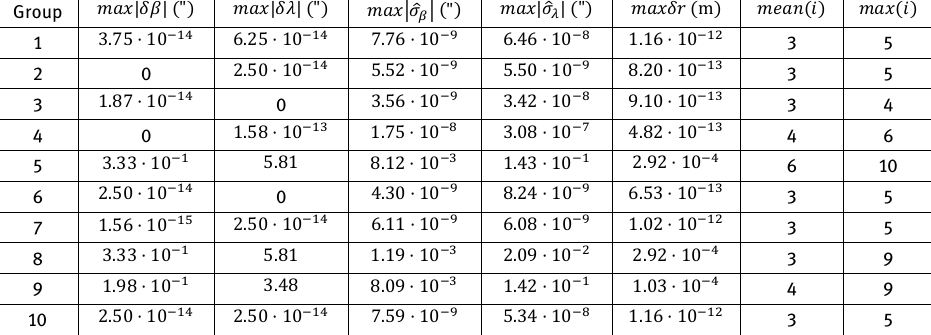
Table 3: Performance of the numerical method using double precision Group